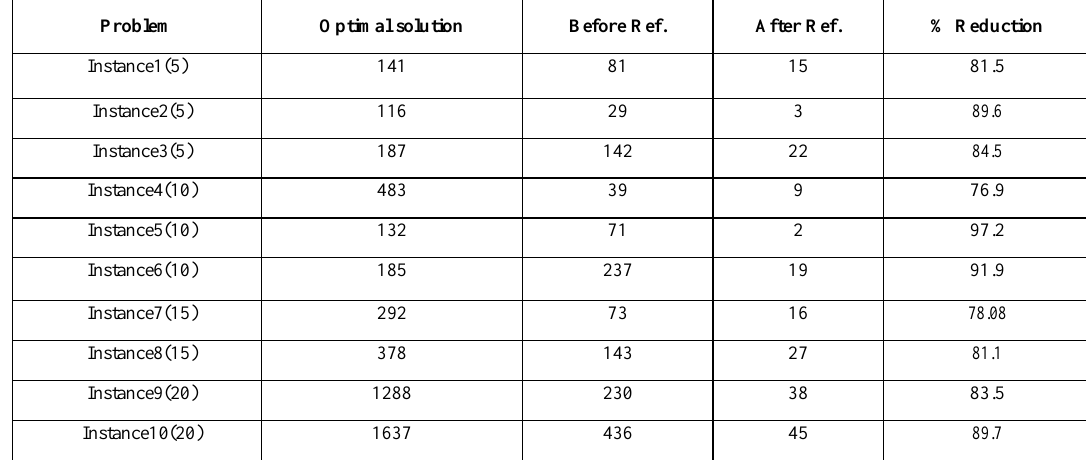
Table 1. Comparison with respect to the number of sub-problems before and after the reformulation using the branch and bound on Tora software